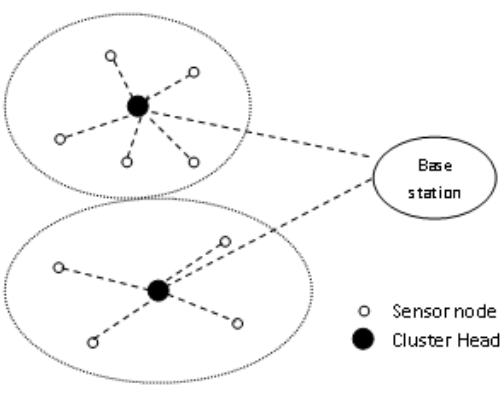
Figure 2. Clustering in LEACH